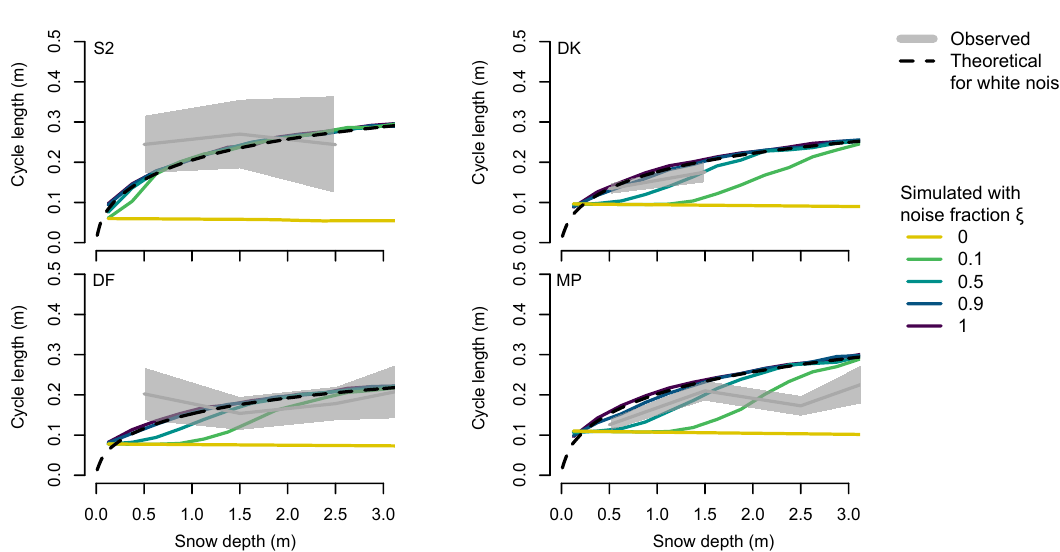
Figure A2. As Fig. 7 but for the remaining sites which only have a single isotope firn profile. Observed cycle lengths (grey line) and a 2 standard error estimation uncertainty (grey band) are shown. Simulated cycle lengths are shown for various noise fractions in the input signal (coloured lines). In addition the theoretical cycle length for pure white noise is shown (dashed